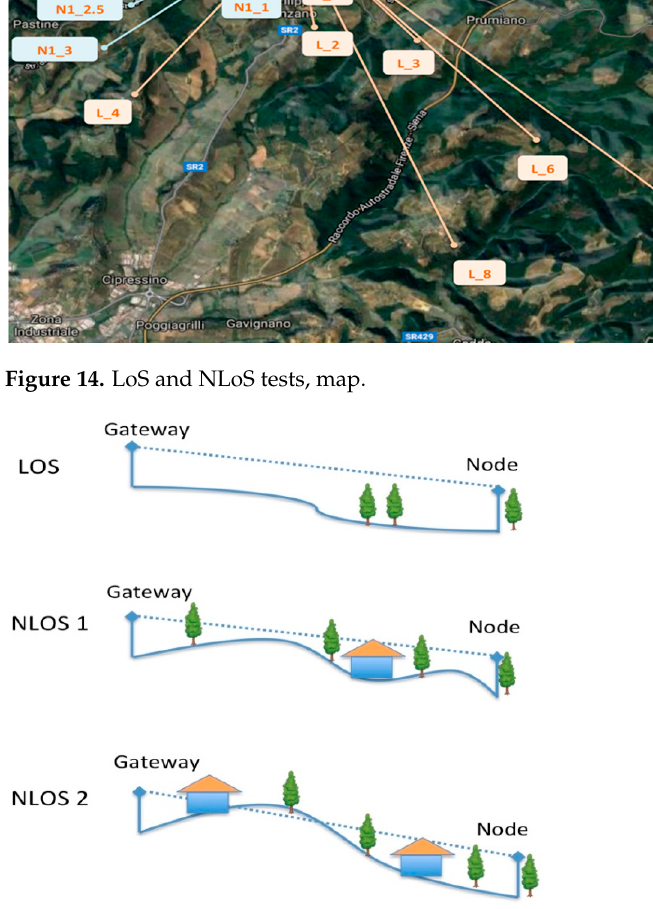
Figure 15. LoS, NLoS1 and NLoS2 cases.